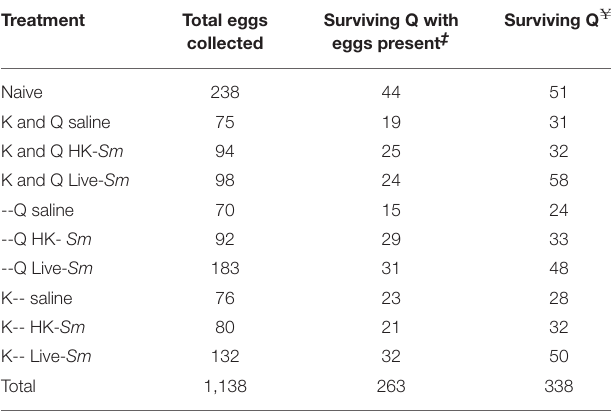
TABLE 1 | Sample sizes (number of incipient colonies) per parental treatment.